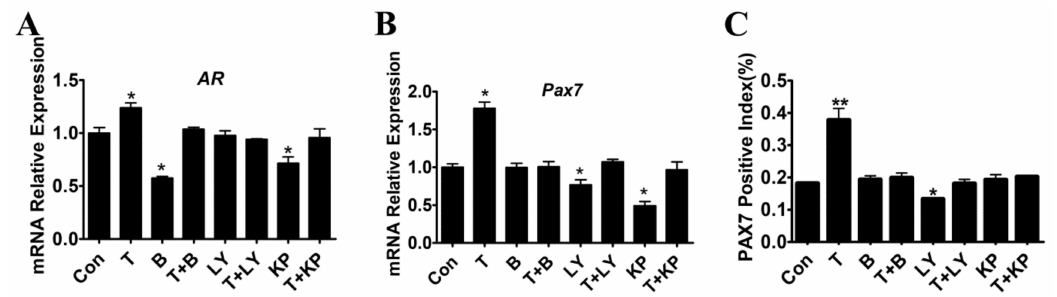
Figure 6. E ff ect of T and inhibitors on the expression of PAX7 in cultured myoblasts. ( A–B ): The mRNA expression of AR and Pax7 after T and / or inhibitors treatment was measured by qRT-PCR. ( C ) The positive index of PAX7 in cultured myoblasts treated with T and / or inhibitors. Asterisk (*) represents statistically di ff erent ( p < 0.05), ** indicates that the di ff erence is extremely significant ( p <